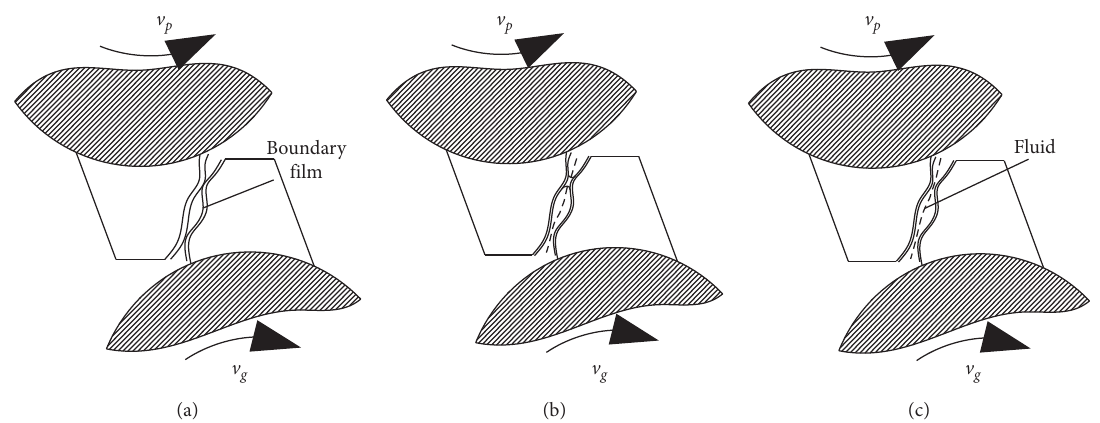
Figure 4: Lubrication states: (a) boundary lubrication, (b) mixture lubrication, and (c) fluid